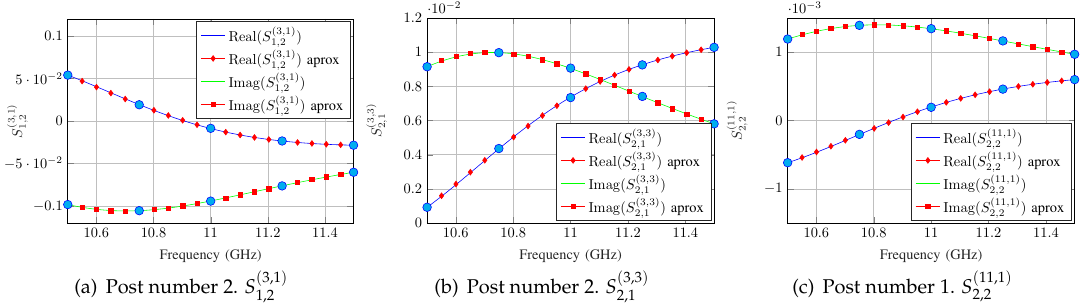
Figure 9. Comparison between accurate and approximate S dielectric loaded filter for different number of discrete points P . Big dots show the points used for spline approximation.